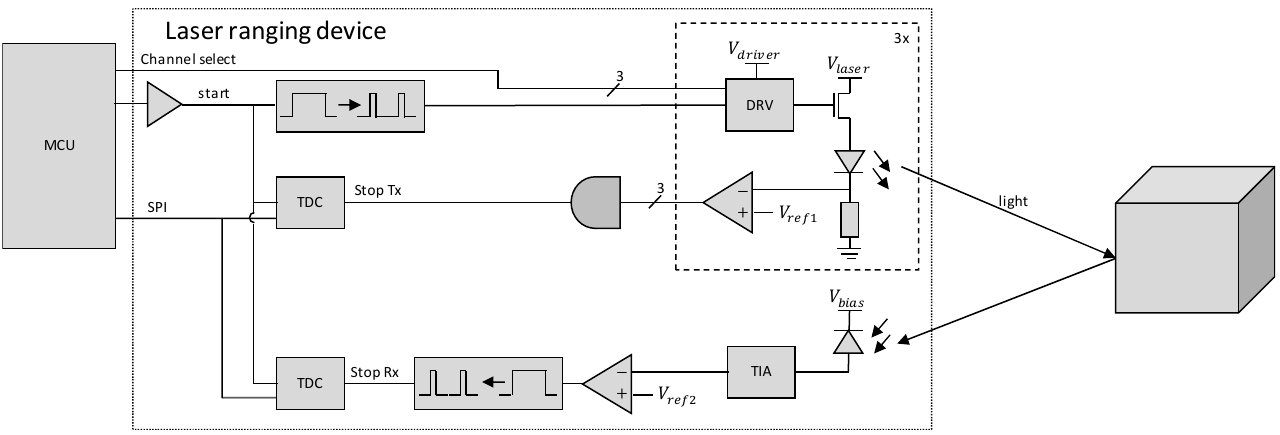
Figure 3. Block diagram of laser ToF ranging device. Dotted line encircles the crucial components that are mounted on the same PCB. The dashed line encircles the components of one of three transmit channels, constructed in the same way.